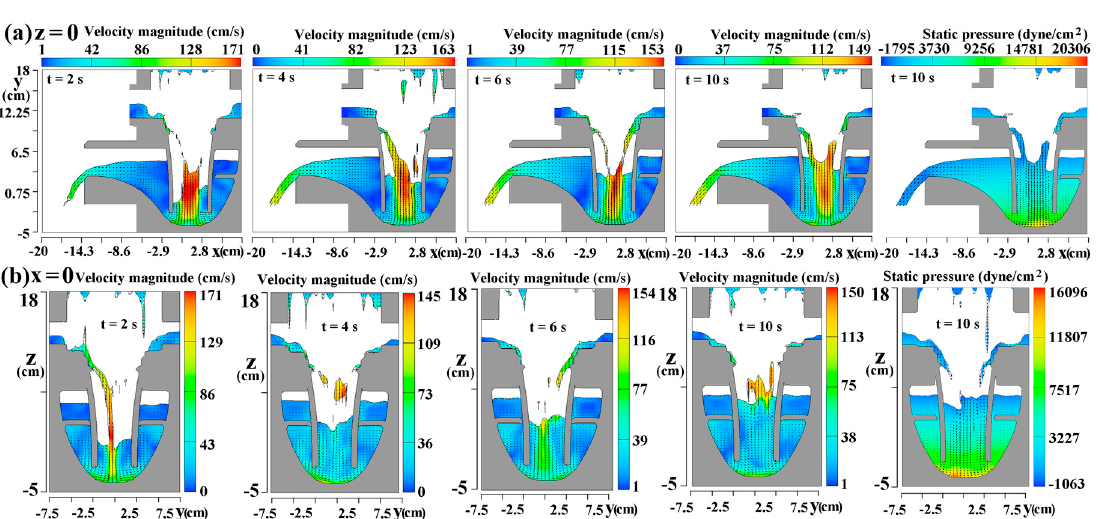
Figure 5. Distributions of velocity and static-pressure at t = 2, 4, 6, 10 s on: ( a ) z = 0; and ( b ) x = 0 planes for test gully with downward nozzle flow with Q floor = 0.6 L/s. The transportations of 3000 glass balls that randomly fall into the gully from the top entry within the entry water flow at 0.6 L/s are displayed by viewing the sequential flow snapshots predicted at t = 10, 20, 30, 40, 50 and 60 s for the gullies with the beveled and downward nozzle flows in Figures 6 and 7, respectively.